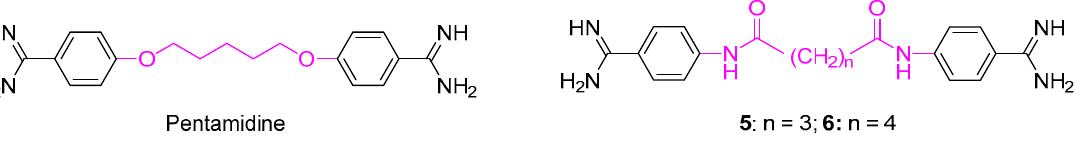
Figure 1. Chemical structures of pentamidine and lead compounds.